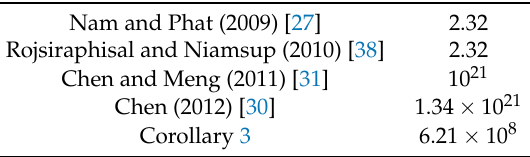
Table 3. The least upper bound of σ for Example 5.